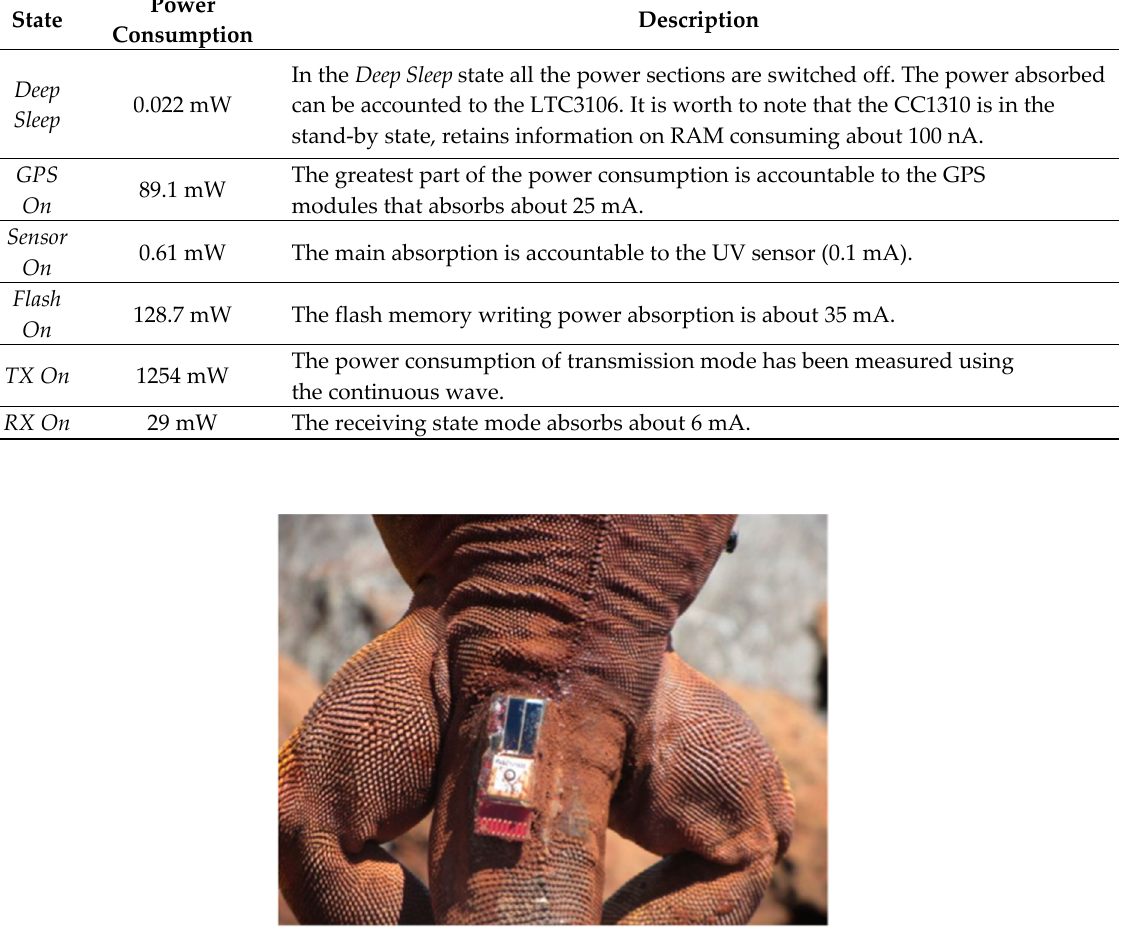
Figure 5. Animal with the device